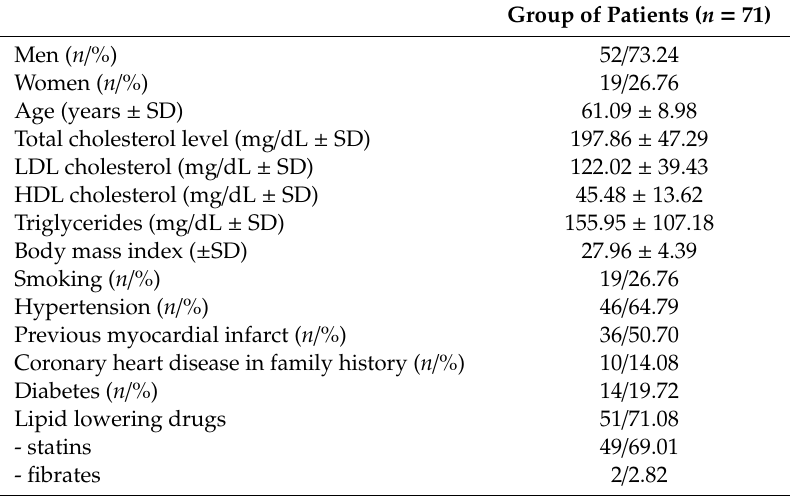
Table 1. Baseline characteristic of investigated